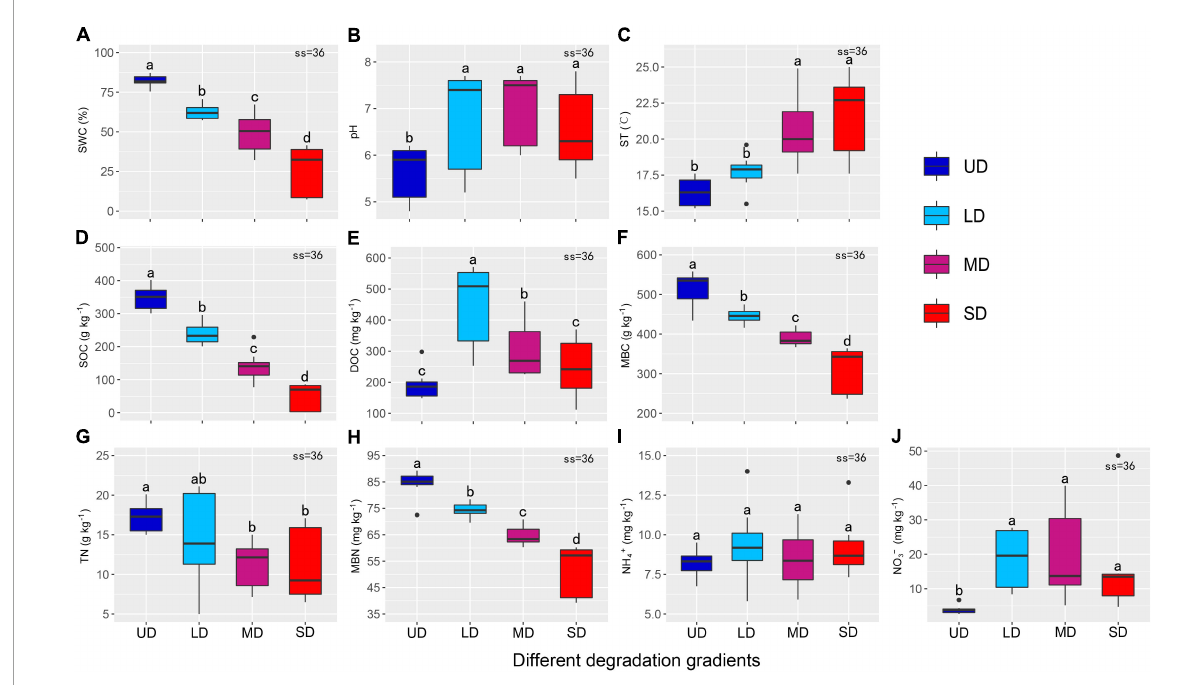
FIGURE2 Environmental factors at the different degradation gradient sites. (A–J) Represent the trends of SWC, pH, ST, SOC, DOC, MBC, TN, MBN, NH 4 + , and